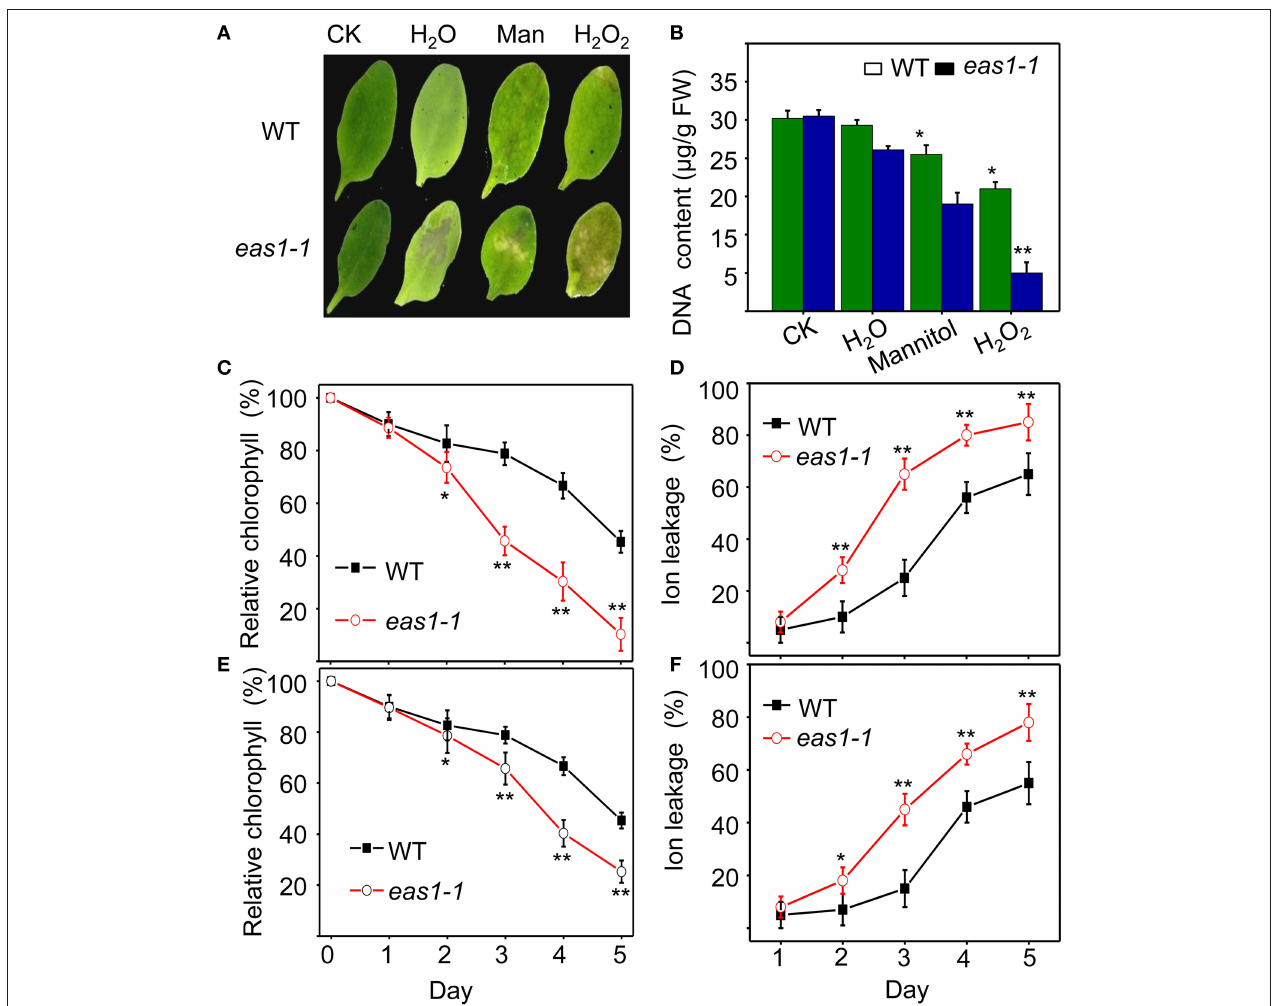
FIGURE 2 | EAS1 mutations accelerate leaf senescence under osmotic and oxidative stresses. (A) Aging symptoms of detached leaves from wild-type and e as1-1 mutant plants under different stresses (deionized water, 500mM mannitol, and 10mM H 2 O 2 ,for 3 days).The sixth rosette leaves grown for 25 days under unstressed conditions in soil are treated. (B) DNA content in leaves of different treatments corresponding to panel (A) . (C,D) Relative chlorophyll contents of wild-type and eas1-1 leaves under 10mM H 2 O 2 (C) and 500mM mannitol (D) treatments at different stress times. (E,F) Ion leakage of wild-type and eas1-1 plants at different times under 10mM H 2 O 2 (C) and 500mM mannitol (D) treatments. Three experiments were performed with similar results. Error bars indicate standard deviations, while asterisks indicate significant differences from wild-type plants under Student’s test ( * p < 0.05 , ** p < 0.01